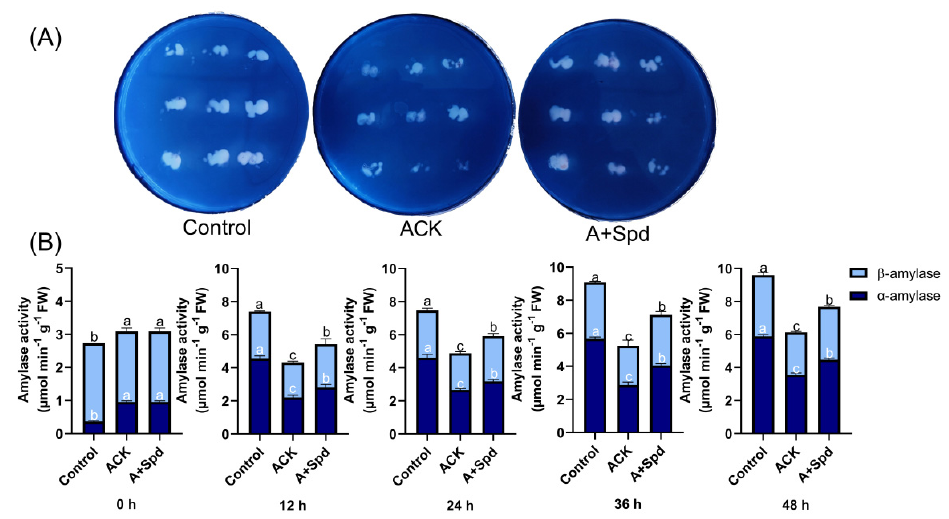
Figure 2. Effects of exogenous Spd on soluble sugar ( A ) and starch ( B ) at the germination stage of aged sorghum seeds. Control − healthy seeds; ACK − artificially aged seeds; A+Spd − aged seeds with Spd treatment. A total of five time points from 0 to 48 h after germination were performed for each treatment, and the different lowercase letters above the bars indicate significantly different levels among the treatments ( p < 0.05, Lsd). A 0.05 μ M concentration of exogenous Spd was used.